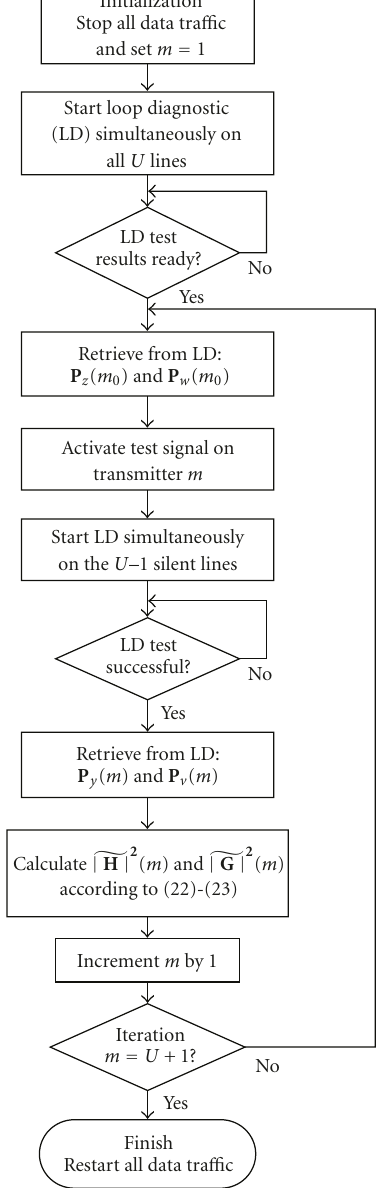
Figure 5: Flow chart of the FEXT and NEXT channel estimator, based on the two-port loop diagnostic (LD) protocol.